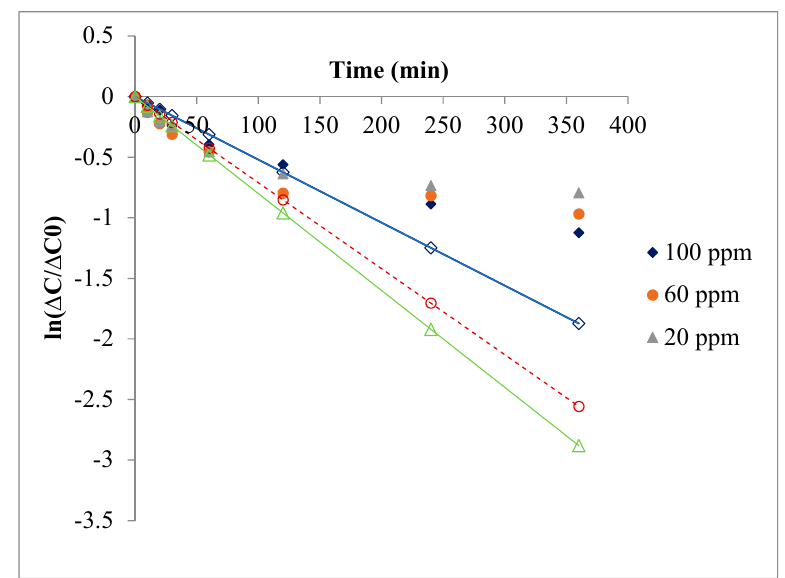
Figure 4. As(V) concentration vs time. Aqueous phase: pH = 6.98; Flow-rate: 0.47 mL/s. Organic phase: [Aliquat-336] = 30% ( v / v ) + Kerosene + 4% ( v / v ) octanol; flow-rate: 1.4 mL/s; Membrane: PVDF hollow fiber, T = 25 °C. ∆ P = 0.3 bar. Table 3. Overall mass transfer coefficients of As(V).